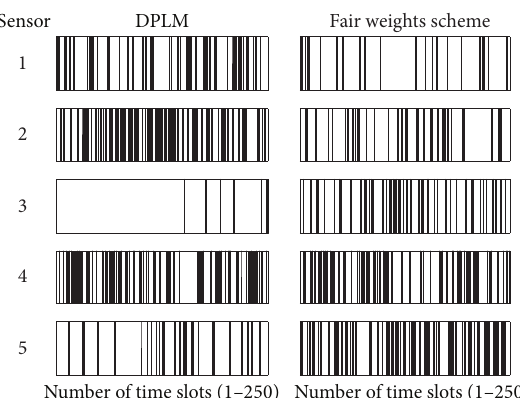
Figure 8: Scheduled time slots of sensors 1 to 5 versus time for DPLM and fair weights